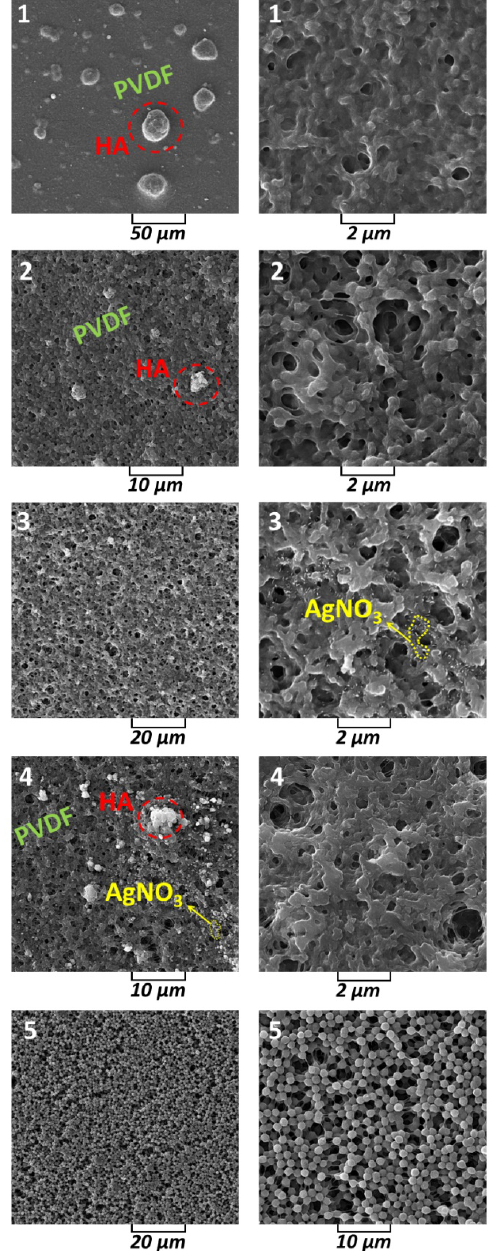
Figure 6. SEM images of samples 1, 2, 3, 4, and 5 at two different magnifications .